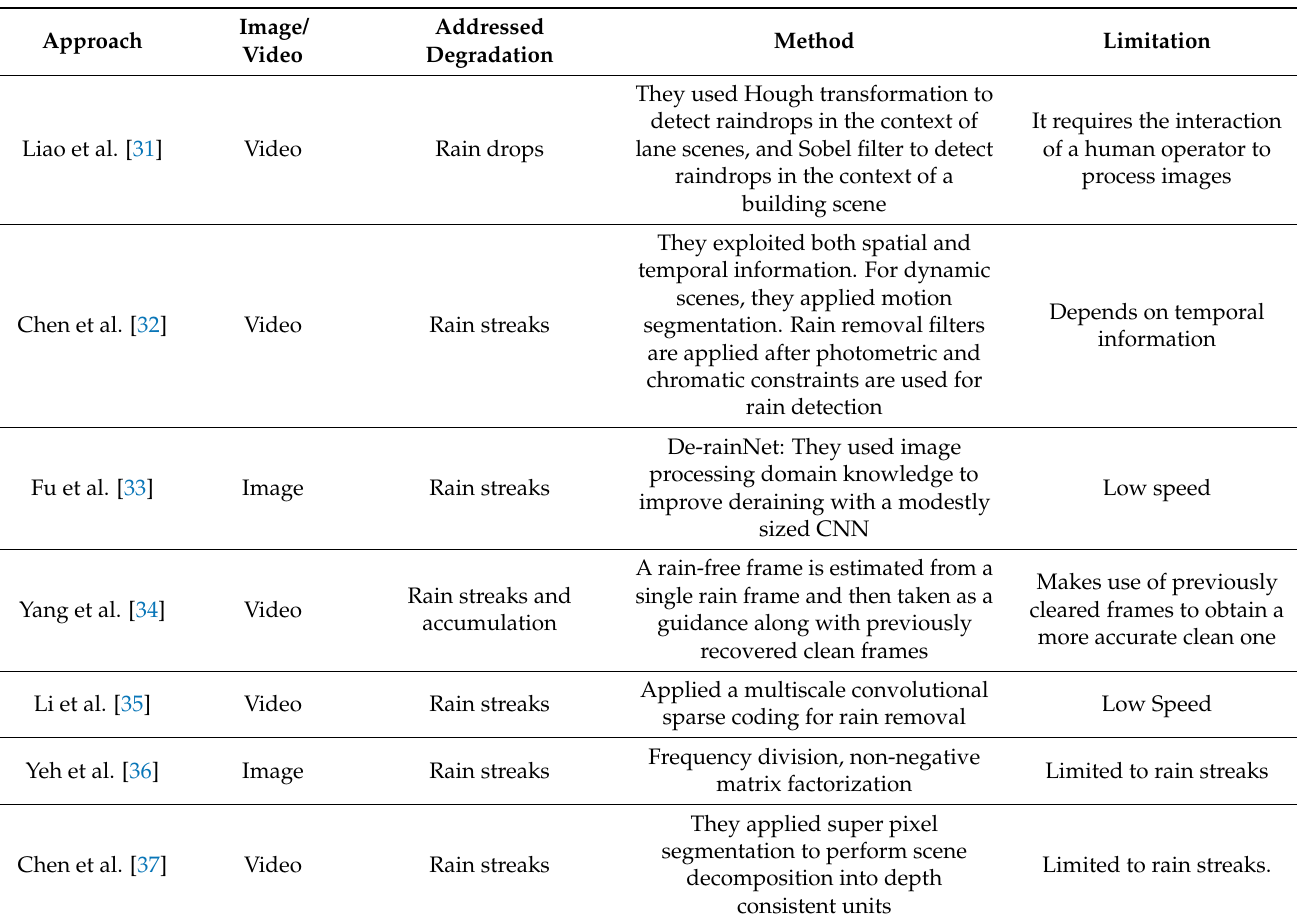
Table 1. Rain detection and removal